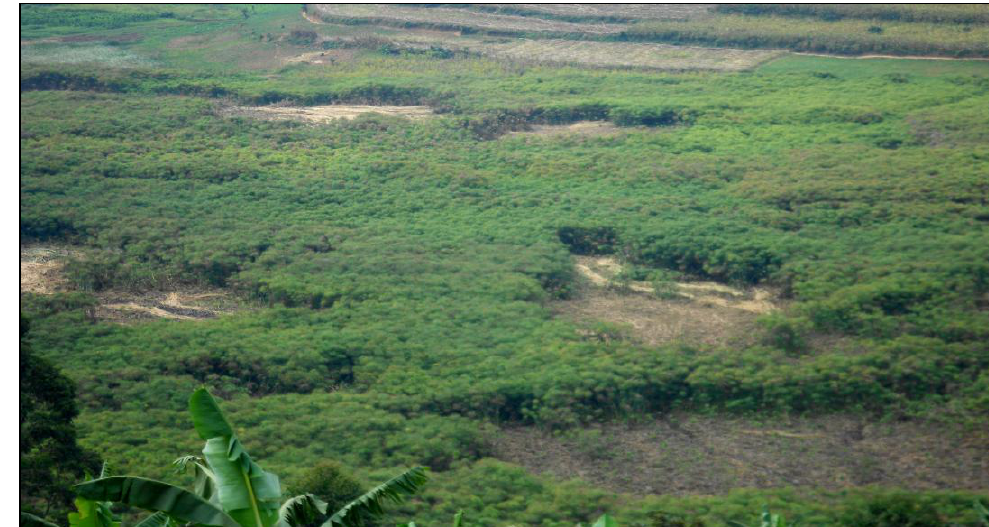
Fig. 4. Big pockets left due to over harvesting of wetlands resources in the un-reclaimed wetland by members of the local community in the Western Region, by Alex Barakagira, 2013